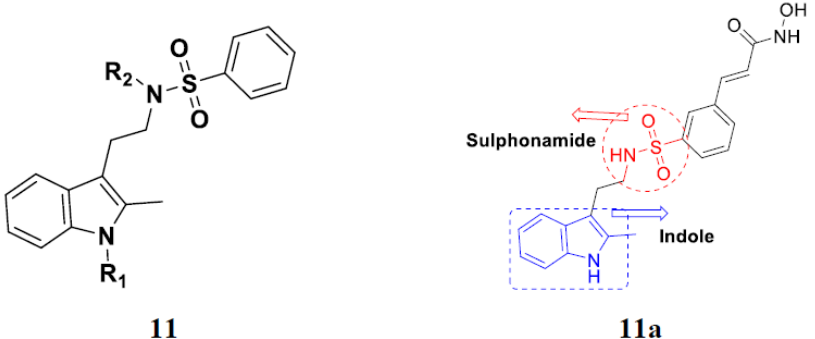
Figure 13. Structure of indole with sulphonamide hybrids and the most promising compound 11a . Table 11. In vitro cytotoxic activities of hybrid compounds 11 ( b – e ). Compound